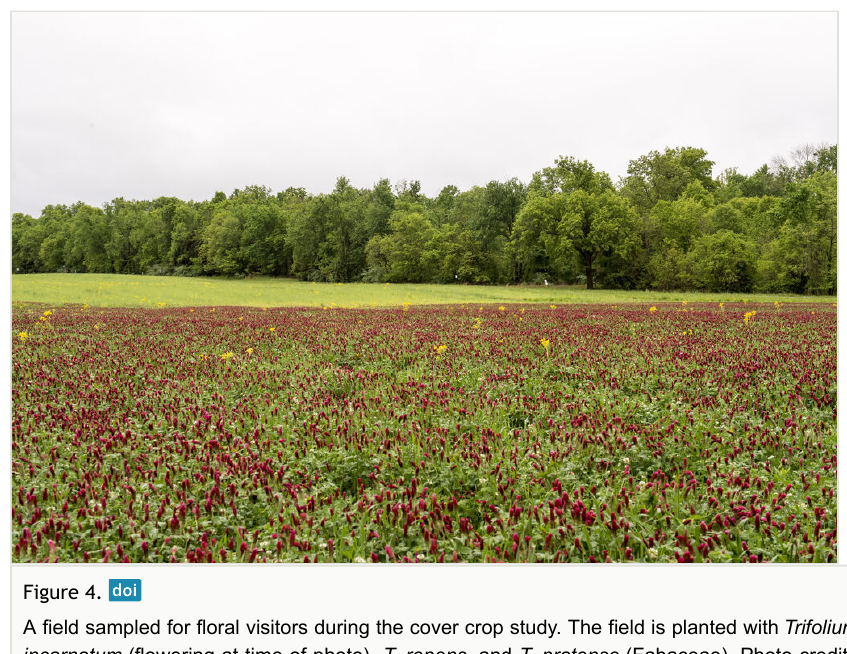
Figure 4. A field sampled for floral visitors during the cover crop study. The field is planted with Trifolium incarnatum (flowering at time of photo), T. repens , and T. pratense (Fabaceae). Photo credits SIUC photographer Russell Bailey.